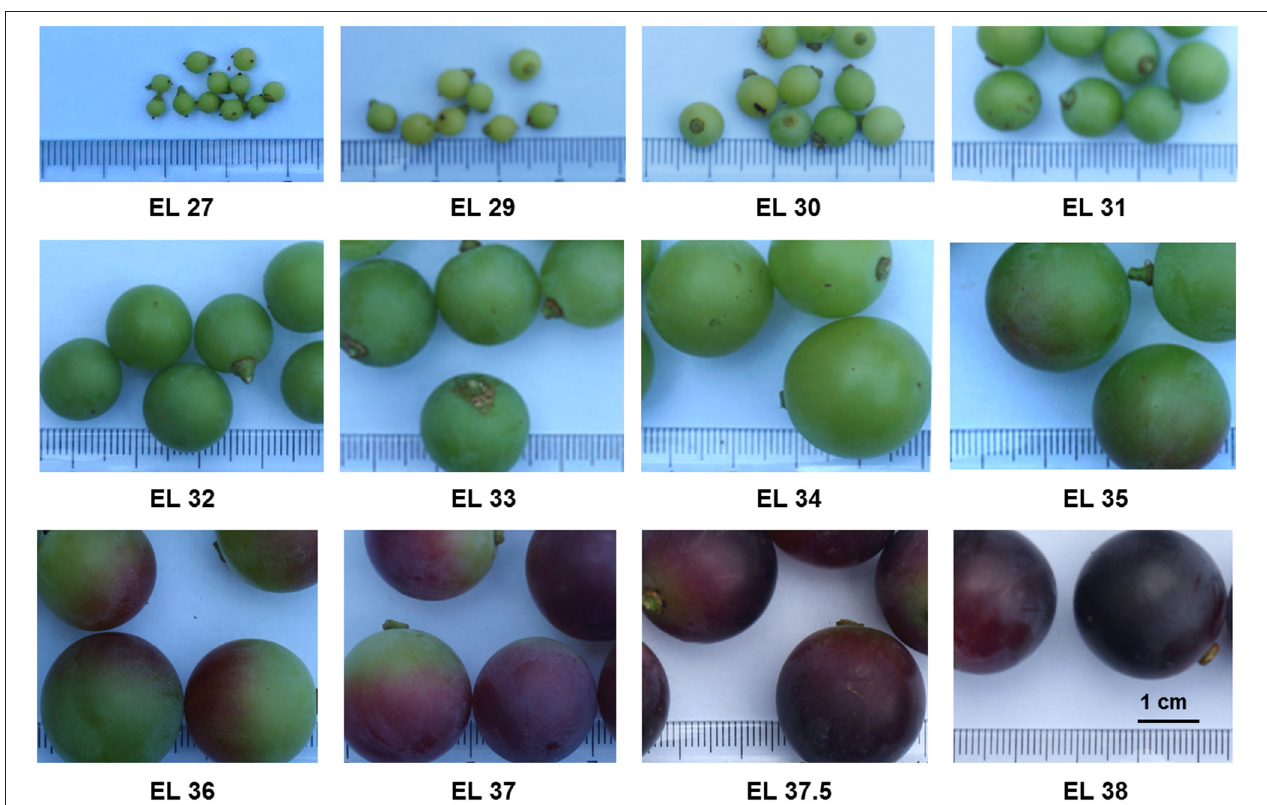
FIGURE 1 | Grape berries harvested at 12 developmental stages according to the modified E-L